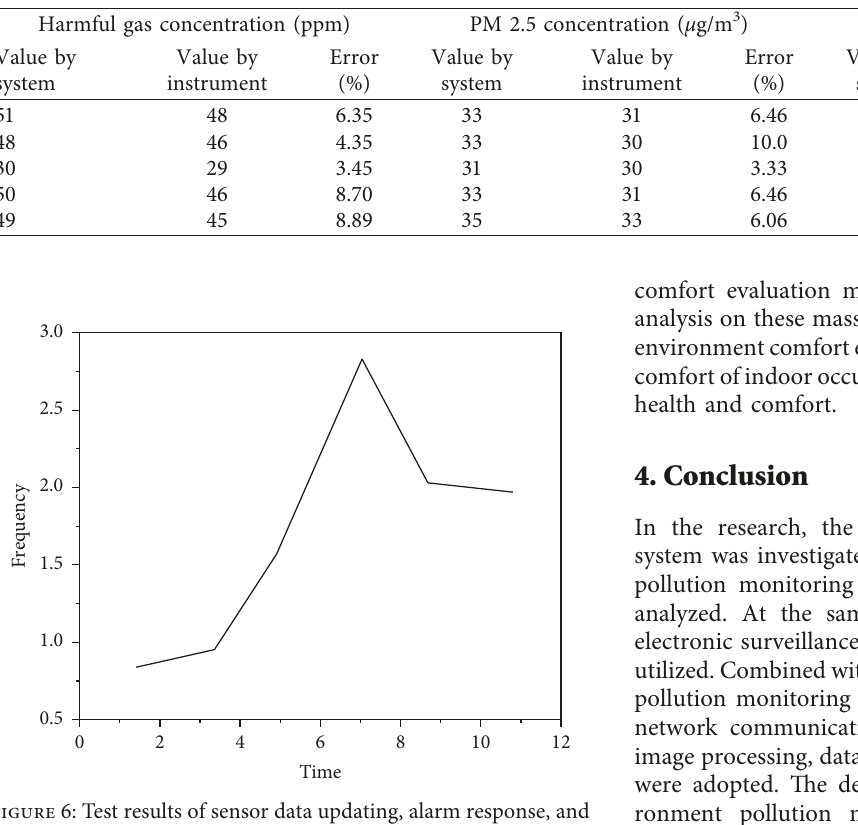
Table 1: Comparison between the harmful gas concentration, PM 2.5 concentration, and noise intensity measured by the system and the measured values by the instrument.